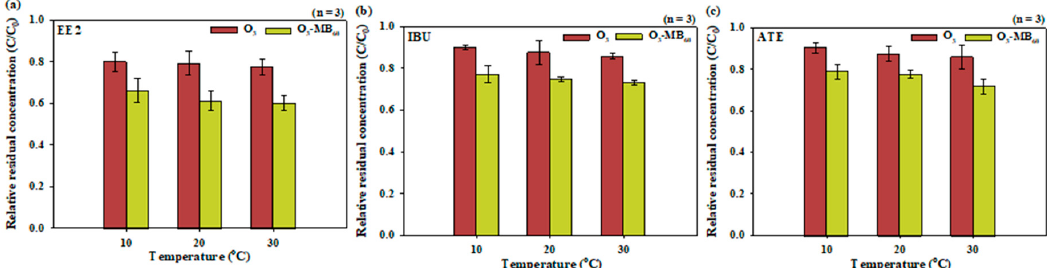
Figure 5. The effects of the temperature on the degradation of the pharmaceutical compounds during the millibubble and microbubble ozonation processes (the initial concentration of each pharmaceutical compound = 2.0 µ M; cavity pump frequency = 60 Hz; pH = 7; O 3 = millibubble ozonation at 30 Hz; O 3 -MB 60 = microbubble ozonation at 60 Hz): ( a ) EE2, ( b ) IBU, and ( c ) ATE. Energies 2019 , 12 , x FOR PEER REVIEW